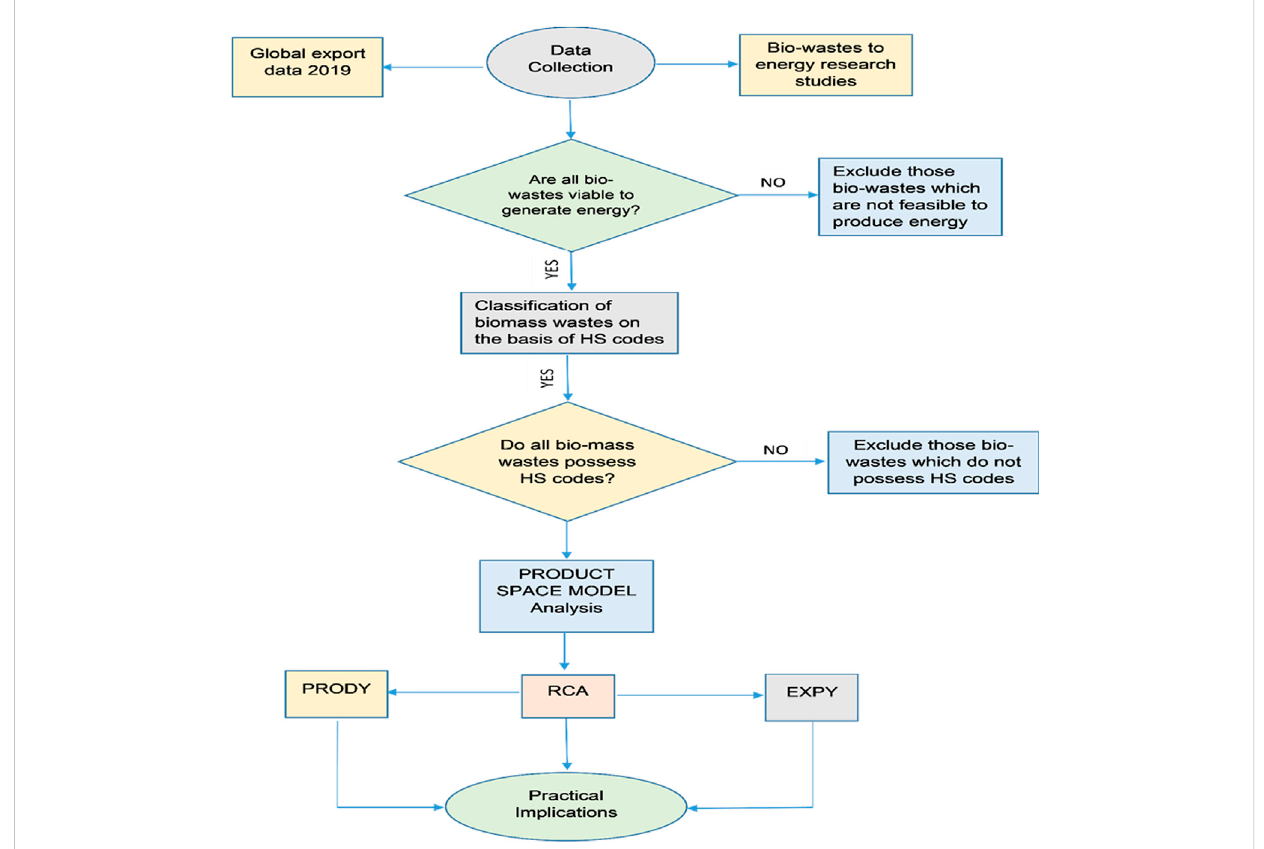
FIGURE 1 Flow pattern for product sophistication and economic growth analysis utilizing